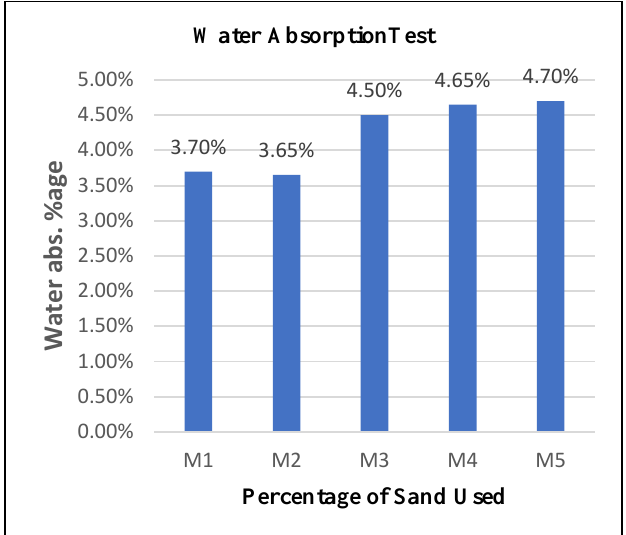
Fig. 6. Water absorption test